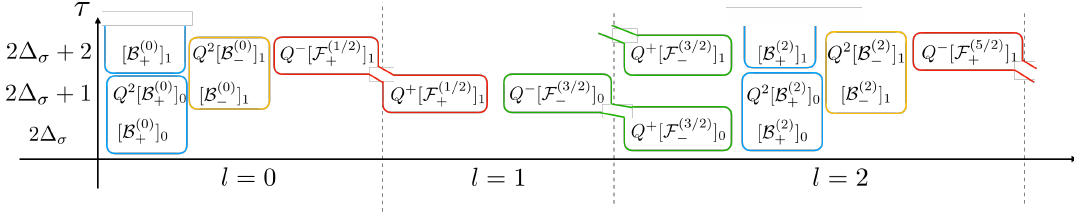
Figure 2 . Low-lying operators of SUSY generalized free fields. Circled operators belong to the same